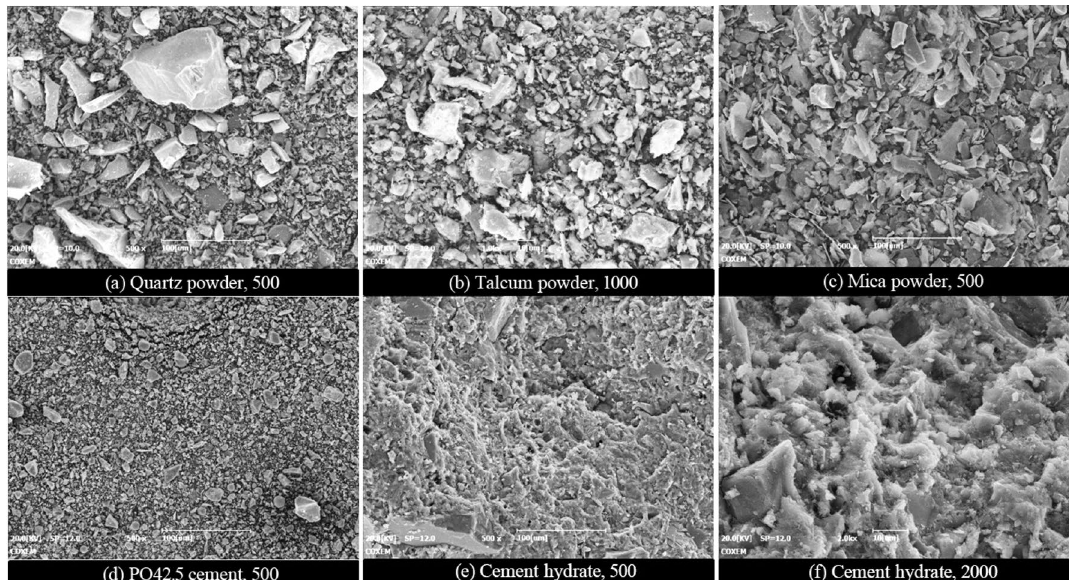
Figure 8. Microstructure of inorganic powder particles and cement